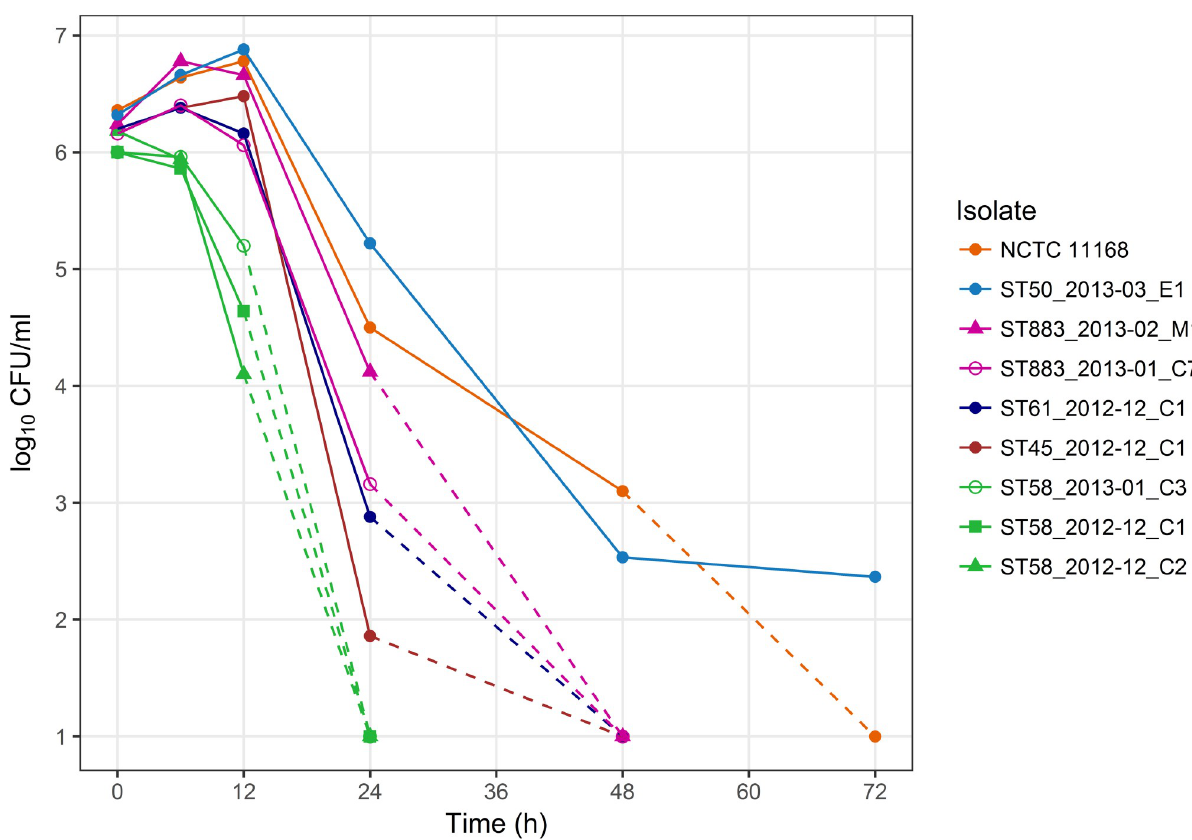
Fig 3. Survival of C . jejuni farm isolates in broth cultures under aerobic shaking at 41.5˚C. Mean colony counts of five experiments are shown at time points 0 h (maximum standard error of the mean ± 0.2), 6 h ( ± 0.3), 12 h ( ± 0.5), and 24 h ( ± 1.2) and mean colony counts of three experiments at 48 h ( ± 2.1), and 72 h ( ± 1.4). Dashed lines indicate the decrease of C . jejuni counts below the quantification limit (1 log 10 CFU/ml): between 12 and 24 h (ST-58 isolates), between 24 and 48 h (ST-883, ST-61, and ST-45 isolates), and later (ST-50 isolate and control strain NCTC 11168). Summary statistics of the data are presented in Table B in S1